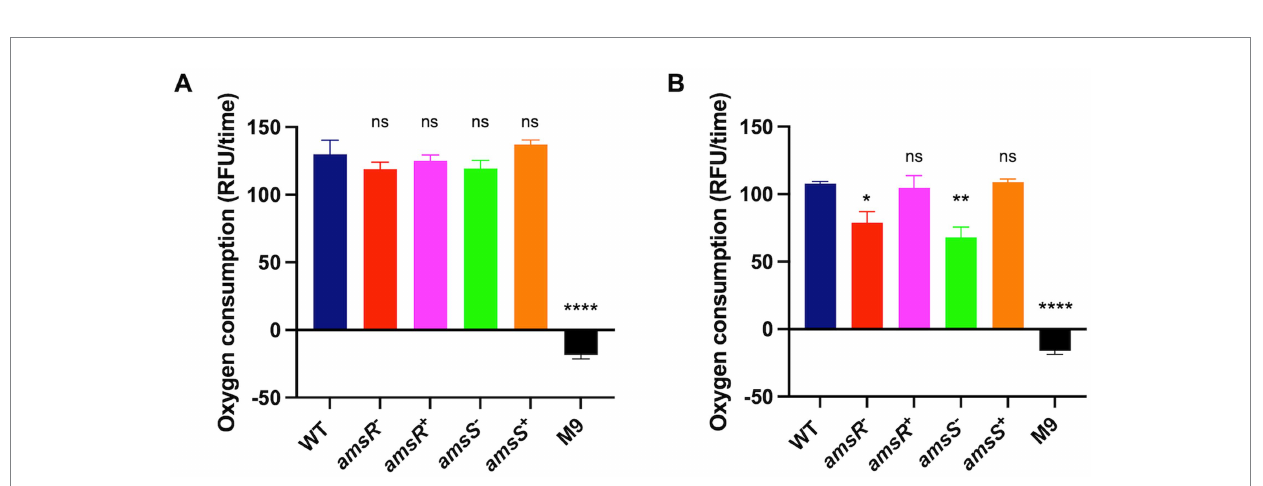
FIGURE 11 amsSR mutants consume less oxygen due to a dysregulated electron transport chain. Extracellular O 2 consumption was measured in strains diluted to an OD 600 of 0.1 in: (A) M9 media supplemented with 1% casamino acids; or (B) M9 media supplemented with 1% casamino acids and 0.2% glucose. All strains were then exposed to 10 μ L of the O 2 consumption reagent, with relative fluorescence measured in black 96-well plates sealed with 100 μ L of mineral oil. The rate of oxygen consumption was calculated after 30 min. Data is derived from three independent biological replicates. Error bars ± SEM. One-way analysis of variance, with Dunnett’s multiple-comparisons test, was used to assess statistical significance in comparison to wild-type, * p < 0.05, ** p < 0.005, **** p <